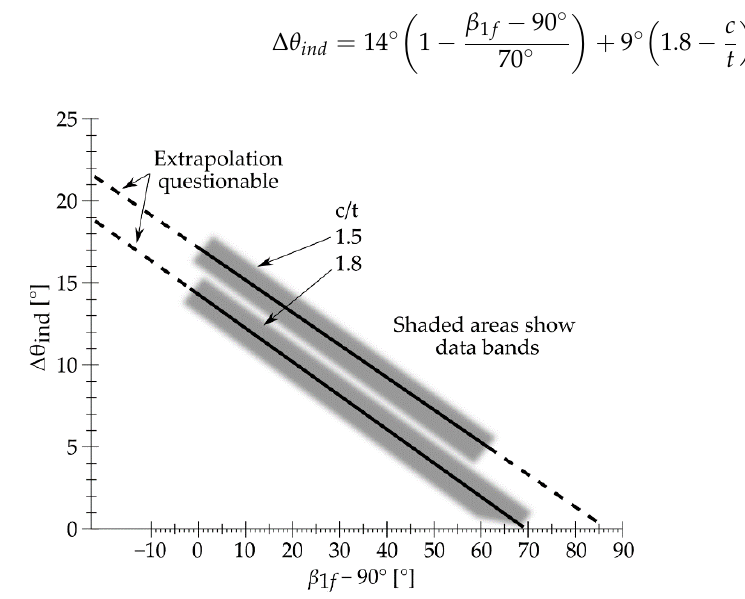
Figure 3. Induced incidence angle by D&E. [11].